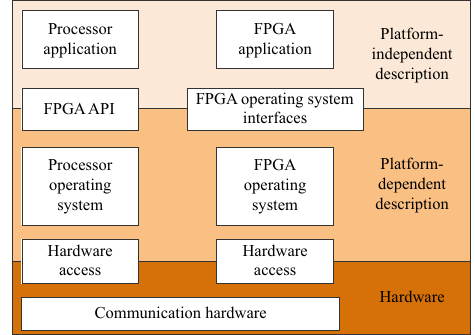
Figure 2: Levels of abstraction of the hardware platform.